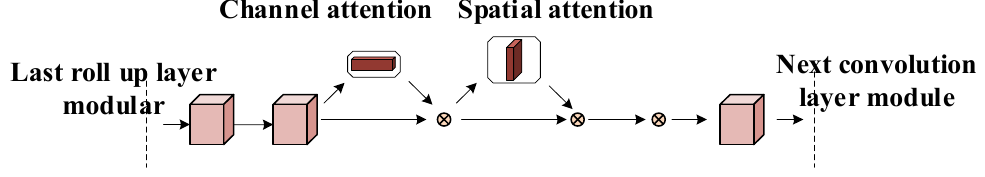
Figure 6. Structure diagram of the CBAM module.